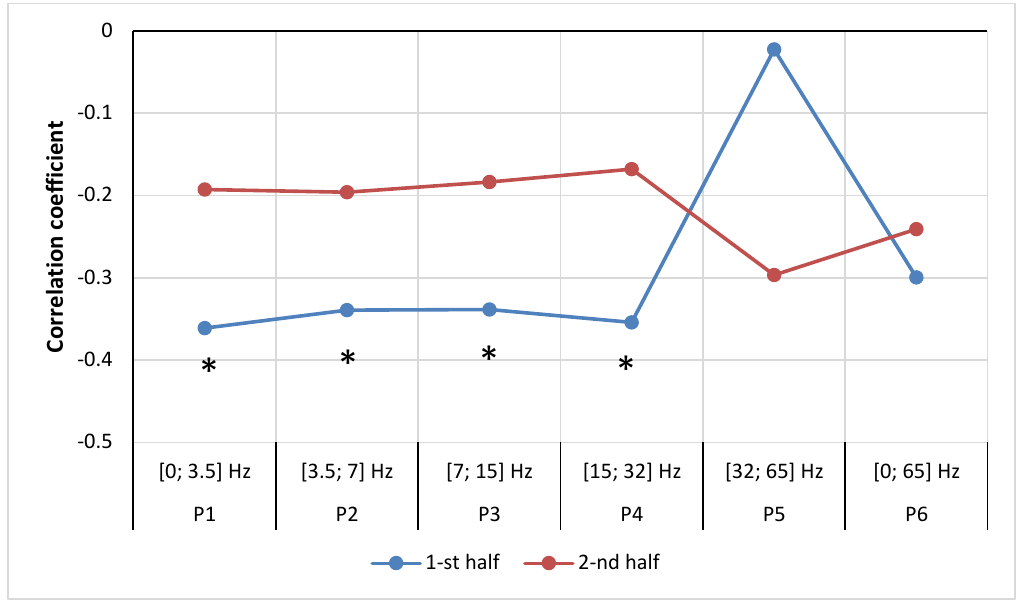
Figure 8. Correlation between number of men weekly cases of MI and mean magnetic power in different frequencies for first and second half of year 2016 (data from LUHS, Cardiology clinic, 2016 year), * p < 0.05.